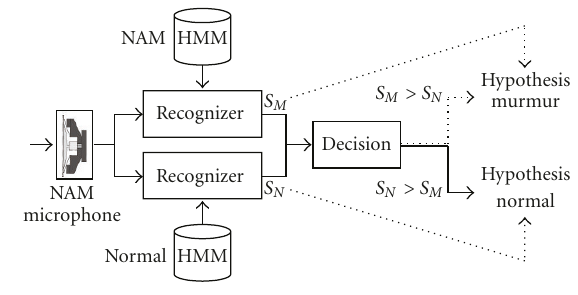
Figure 24: Parallel recognizers-based